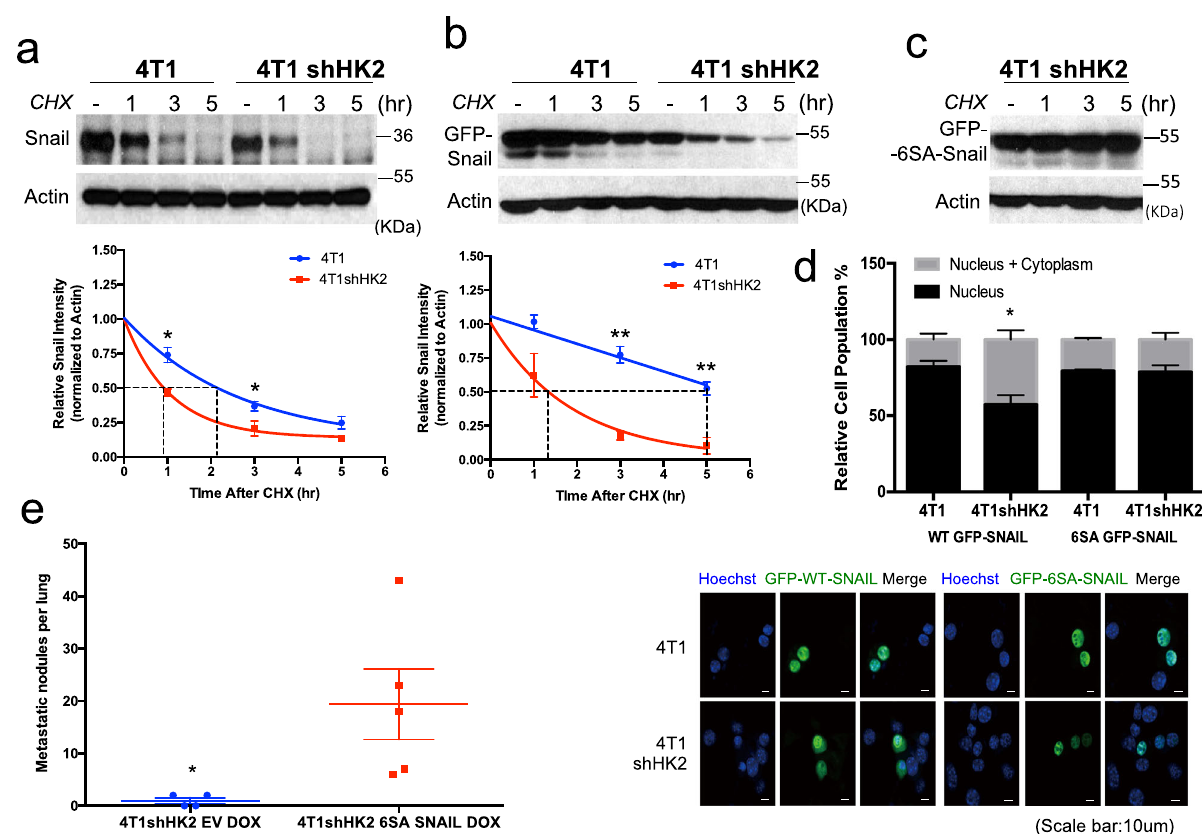
Fig. 9 HK2 silencing in 4T1 cells inhibits SNAIL protein stability and nuclear localization in a GSK3-dependent manner, and SNAIL resistant to GSK3 phosphorylation restores metastasis of HK2-de fi cient 4T1 cells. a Protein stability of SNAIL in 4T1 and 4T1shHK2 cells as measured after exposure to cycloheximide (CHX). Upper: representative immunoblot image. Bottom: plot showing SNAIL protein half-life after quanti fi cation relative to β -actin in three independent experiments. The half-life results are the mean ± SEM. * p = 0.0104 in 1 h, * p = 0.0237 in 3 h versus 4T1; two-sided unpaired t -test. b Protein stability of transiently expressed GFP-tagged SNAIL in 4T1 and 4T1shHK2 cells as measured after exposure to cycloheximide (CHX). Upper: representative immunoblot image. Bottom: plot showing GFP-SNAIL protein half-life after quanti fi cation relative to β -actin in three independent experiments. The half-life results are the mean ± SEM. ** p = 0.0011 in 3 h, ** p = 0.0058 in 5 h versus 4T1; two-sided unpaired t -test. c Immunoblot image showing the level of transiently expressed GFP-tagged 6SA-SNAIL mutant in 4T1shHK2 after exposure to cycloheximide over a 5-h time course in three independent experiments. d GFP-SNAIL and GFP-6SA-SNAIL were transiently expressed in 4T1 and 4T1shHK2 cells. After fi xation of the cells, the localization of SNAIL (green) and nuclei (blue; Hoechst 33342) was examined under a fl uorescence microscope and quanti fi ed (bottom). The bar graph represents the relative GFP-SNAIL localization in the cytoplasm versus in the nucleus in 4T1 and 4T1shHK2 cells in three independent experiments. Each experiment was observed in at least 40 randomly selected fi elds (x400 magni fi cation). Data represent the mean ± SEM; Statistical signi fi cance of the differences was determined by one-way ANOVA (Bonferroni ’ s method); * p = 0.02. e Transient expression of 6SA SNAIL in 4T1shHK2 cells restores metastasis to the lung. 4T1shHK2 cells expressing DOX-inducible empty vector (EV) and 4T1shHK2 cells expressing DOX-inducible 6SA SNAIL were orthotopically implanted in Balb/cj mice (4T1shHK2 EV, n = 4; 4T1shHK2 6SA SNAIL, n = 5) and exposed to DOX for 1 week. At endpoint lung metastatic lesions were quanti fi ed. The results are the mean ± SEM; * p = 0.047 using unpaired two-tailed t -test. Uncropped blots are provided as a Supplementary Fig. 16. Source data are provided as a Source Data fi